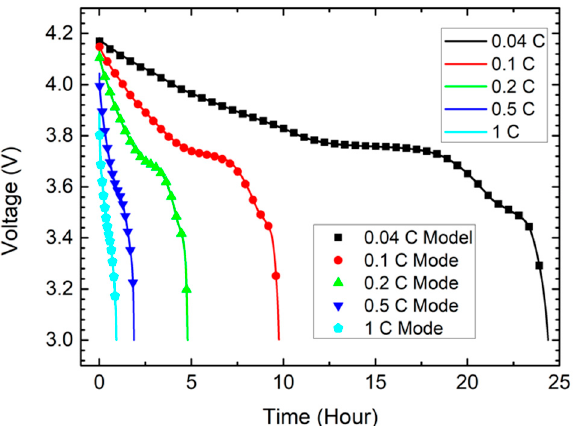
Figure 5. Curve of L brand 18650, Epoch = 100, look_back = 10.